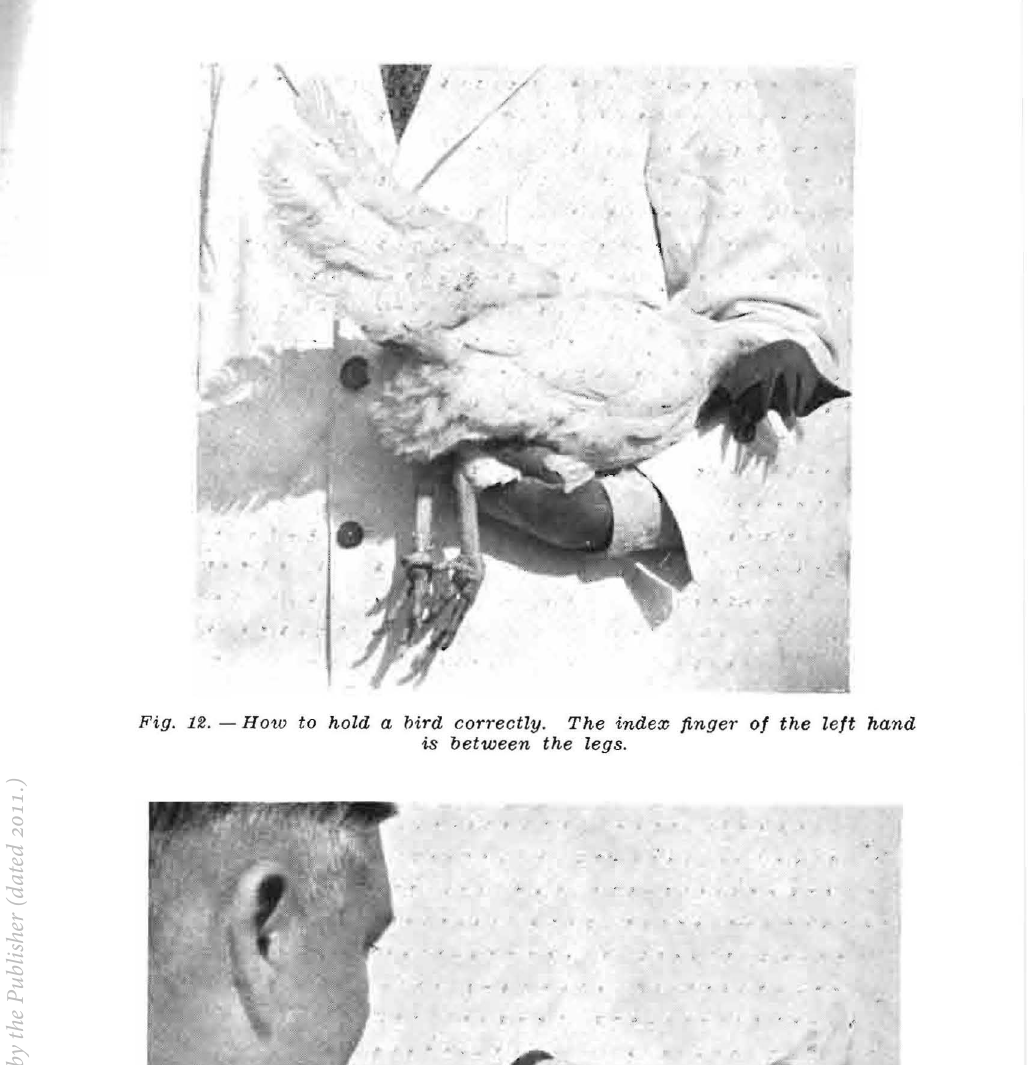
Fig. 12. - How to hold a bird correctly. The index finger of the left hand is between the legs.